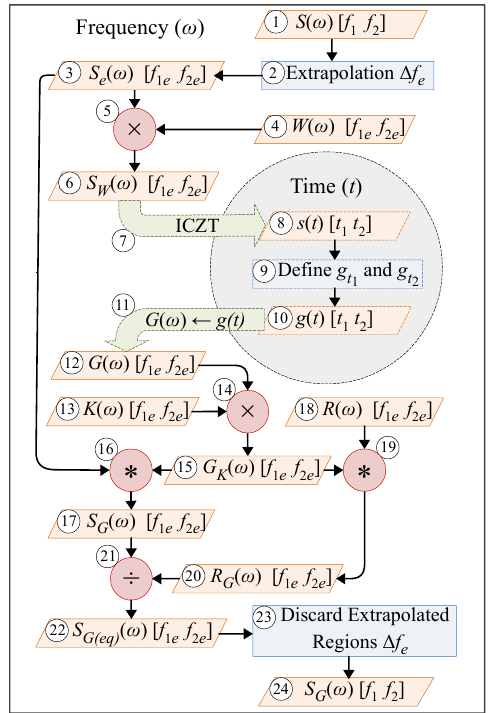
Figure A1. The flow chart of the implemented gating